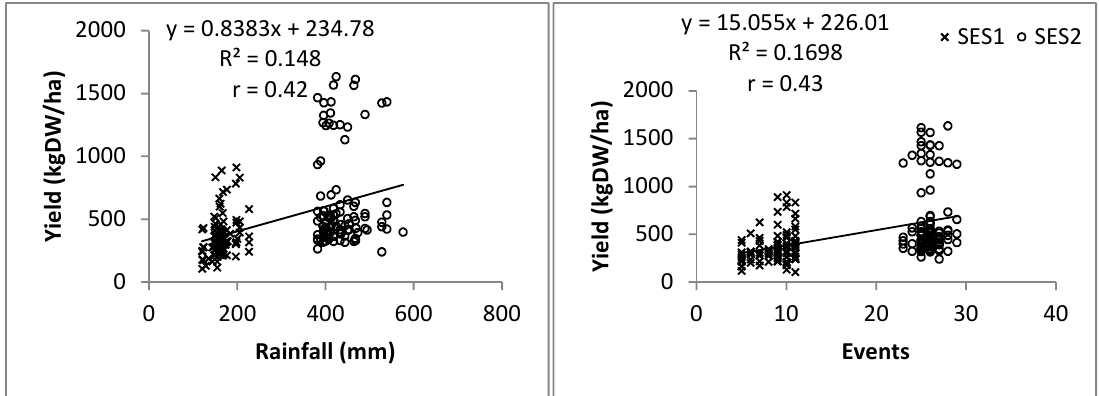
Figure 8. Spatial distribution of pearl millet yield (kgDWha − 1 ) for ( a ) SES1 and ( b ) SES2.